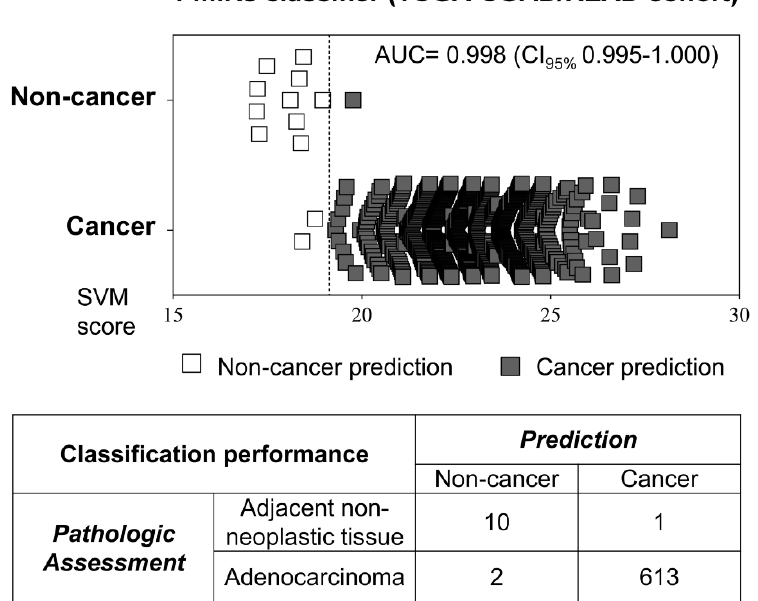
Figure 5. Performance of the four-miR classifier tested in TCGA colorectal primary tumors and ad- jacent non-cancer tissues. The classifier designed to be a liquid biopsy method also demonstrated high power in discriminating cancer and non-cancer colorectal tissues of the TCGA dataset. The dotted line indicates the threshold above which a malignant status would be predicted. TCGA: The Cancer Genome Atlas; COAD: colon cancer cohort from TCGA; READ: rectal cancer cohort from TCGA.